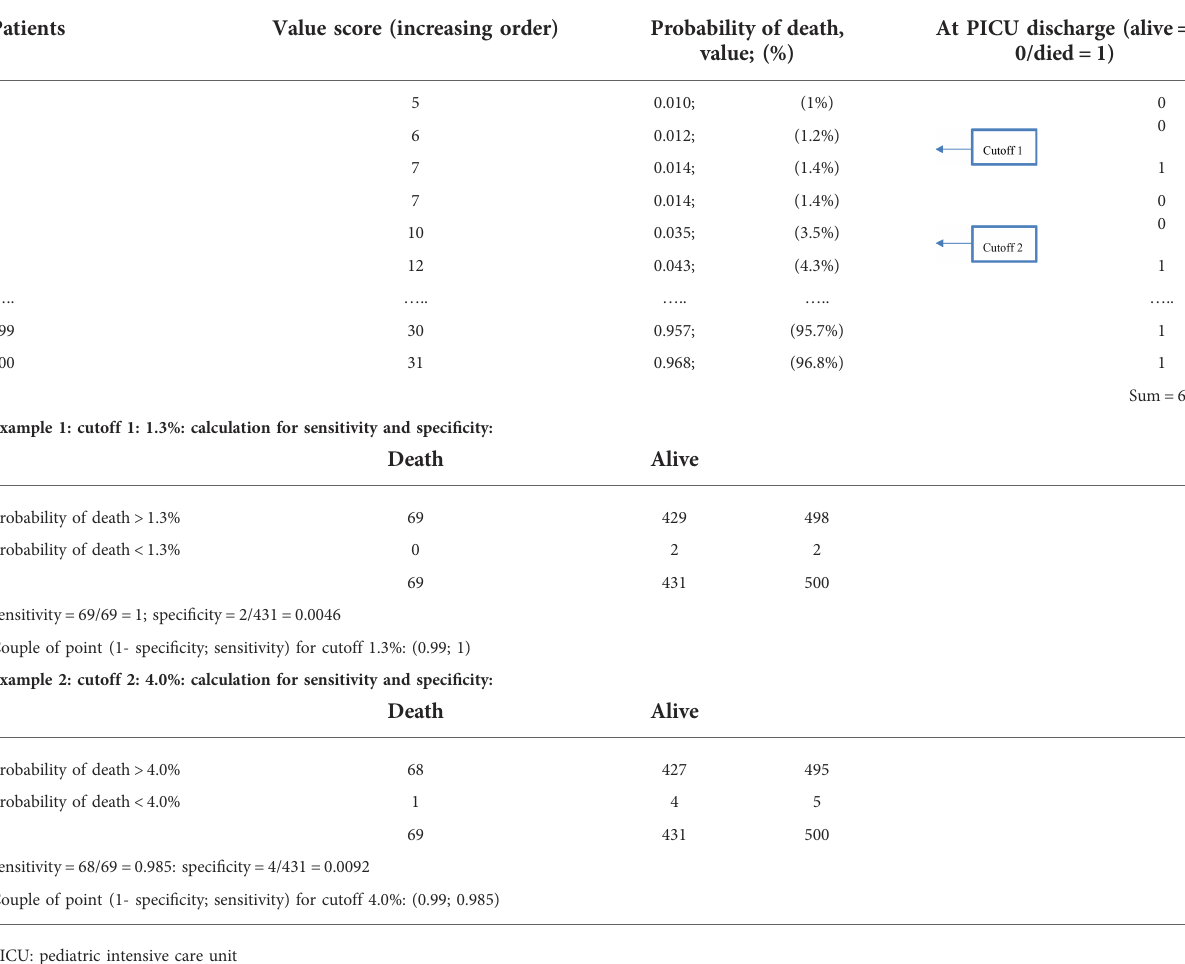
TABLE 2 Example of standardized mortality ratio (SMR) in a population with 500 patients for any score.